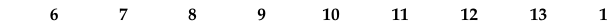
Table 1. Descriptive statistics and correlations for study variables for